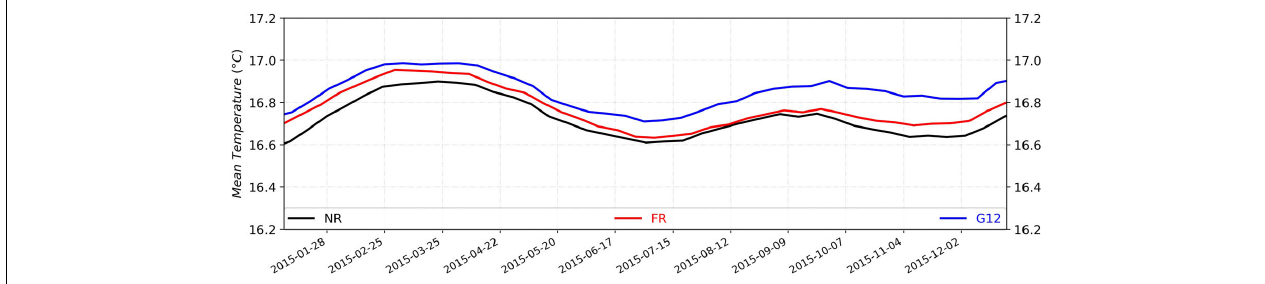
FIGURE 3 | Time evolution of mean temperature between Surface and 100m ( ◦ C) area-averaged (black: NR, red: FR, blue: G12).